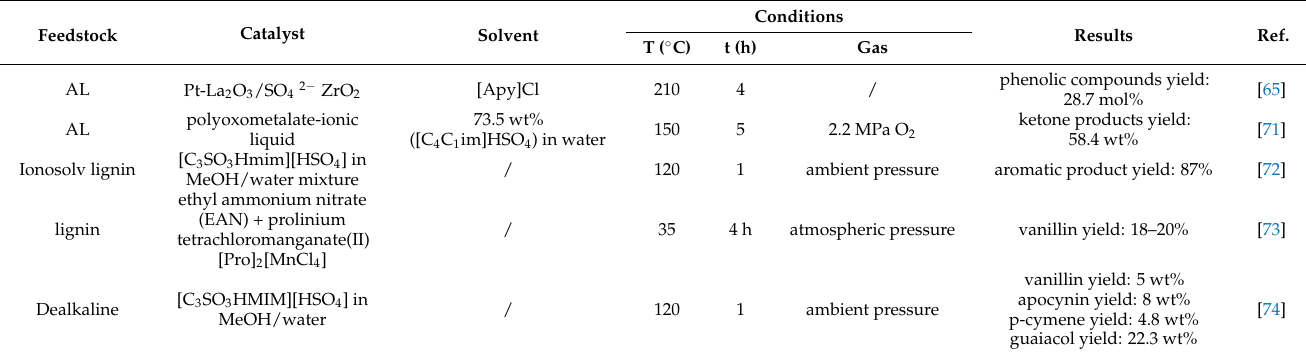
Table 3. Summary of lignin depolymerization using ionic